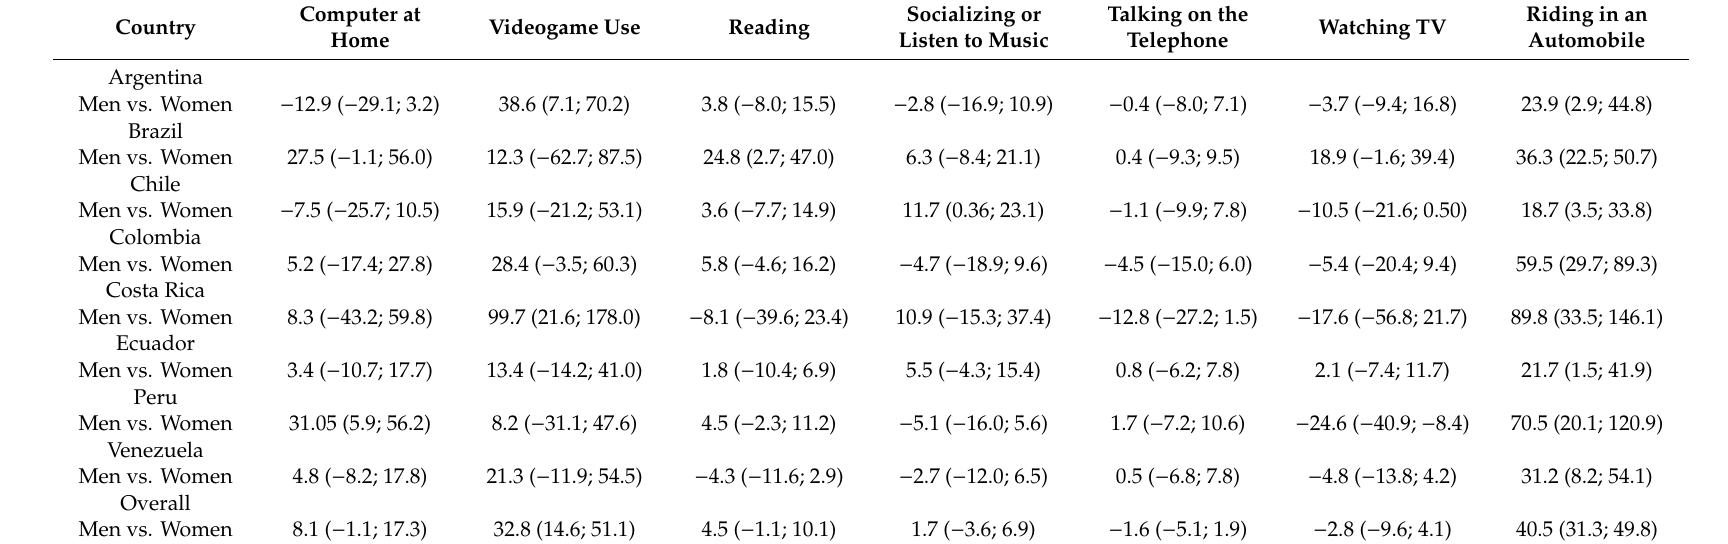
Table 3. Adjusted analyses ( b coe ffi cient (95% CI)) between sex and sedentary behavior by country for specific-domains. Computer at Country Videogame Use Reading Home